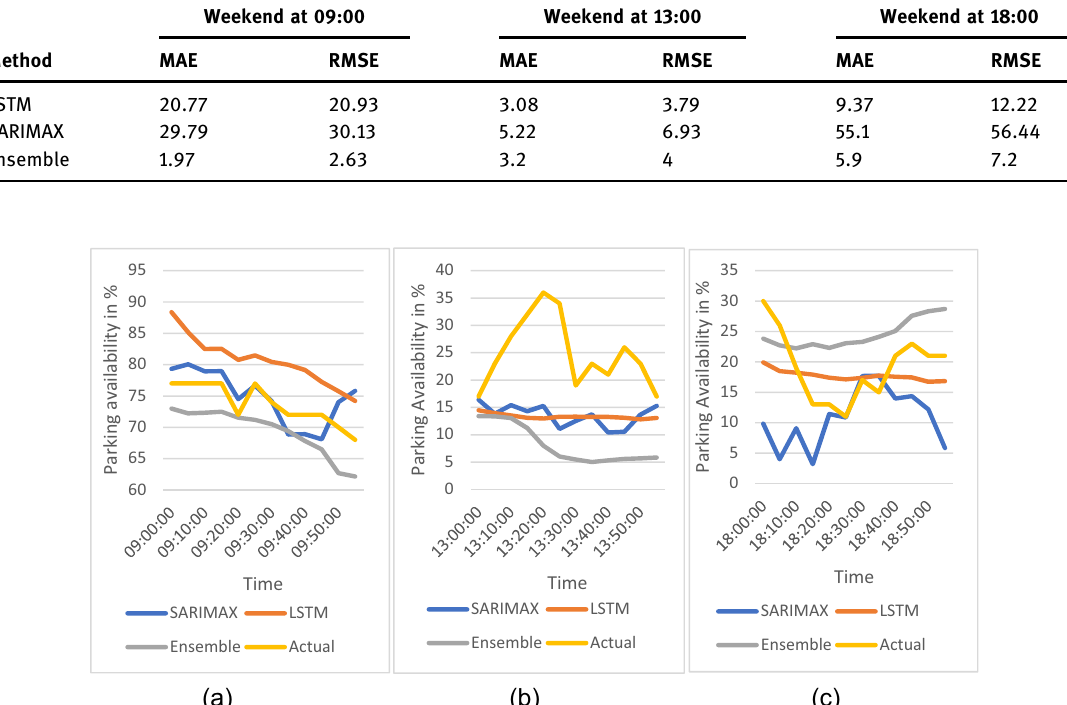
Figure 5: Prediction of parking availability with visitor trend data on weekday. ( a ) Predictions with visitor trend data at 9 AM on a weekday. ( b ) Predictions with visitor trend data at 1 PM on a weekday. ( c ) Parking predictions with visitor trend data at 6 PM on a weekday.